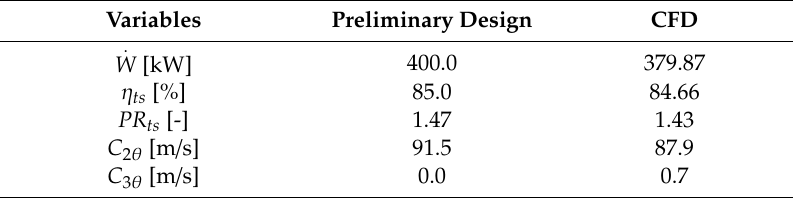
Table 3. Comparison of results between preliminary design and